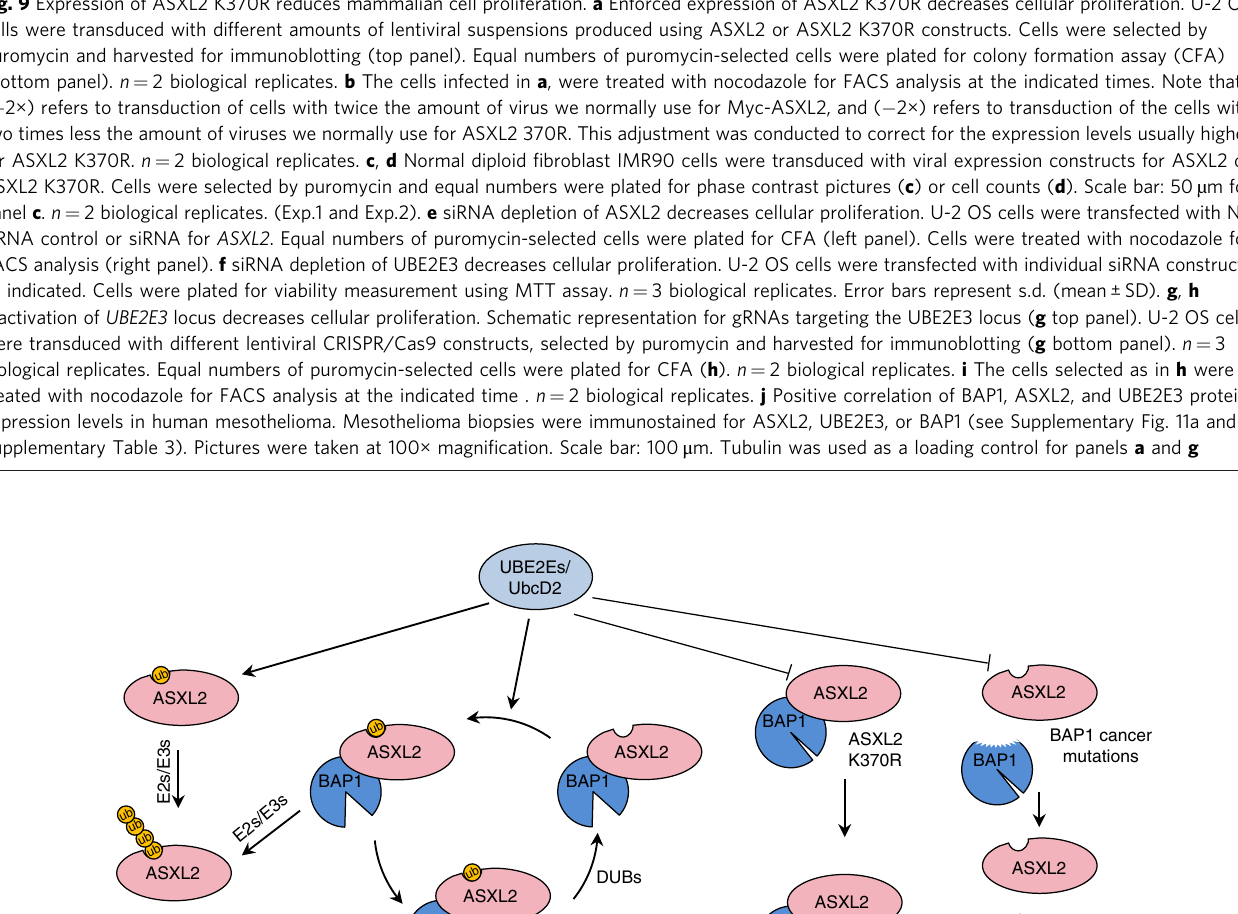
Fig. 10 Regulation of the BAP1/ASXL2 complexes by DEUBAD ubiquitination. ASXL2 is constitutively monoubiquitinated by UBE2Es on its DEUBAD domain. Interaction of monoubiquitinated ASXL2 with BAP1 leads to its stabilization and the subsequent activation of the DUB complex. Otherwise monoubiquitinated ASXL2 is targeted by other E3 Ub-ligases for ubiquitin chain extension and proteasomal degradation. UBE2Es also target ASXL2 already in complex with BAP1, possibly dynamically regulating its activity. DUBs might also regulate the stability of both free and complexed ASXL2. Mutation of ASXL2 lysine 370 or cancer mutations that abolish ASXL2-BAP1 interaction lead to defective monoubiquitination and subsequent loss of BAP1 DUB activity and tumor